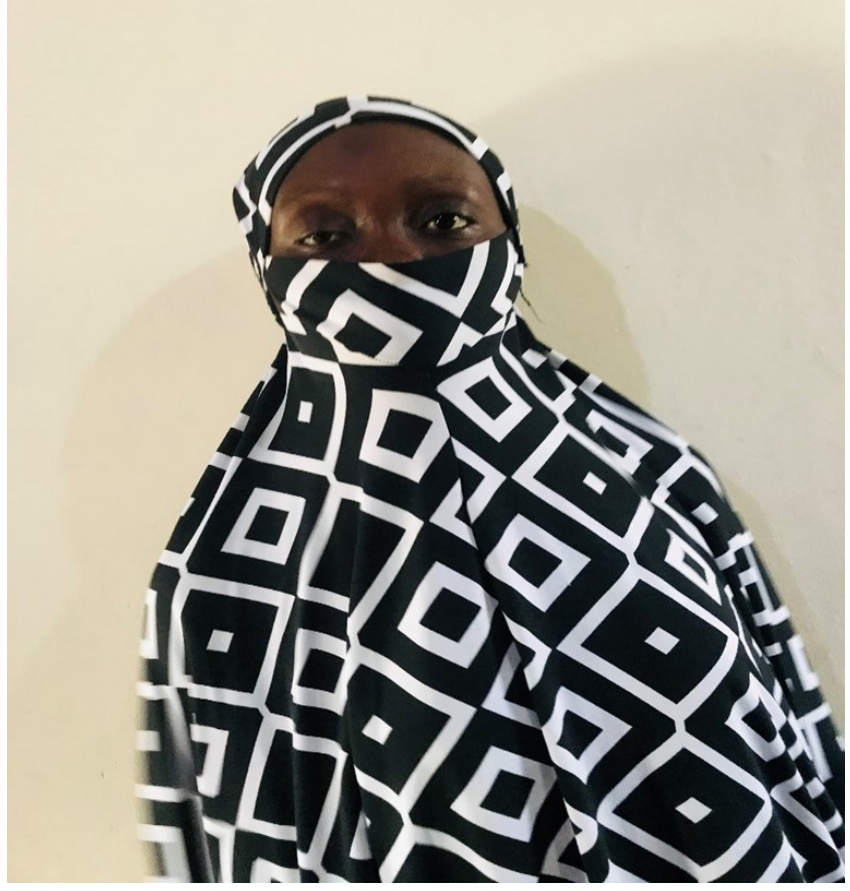
Figure 1 The author in a corona hijab , picture taken by Abdulai Adam